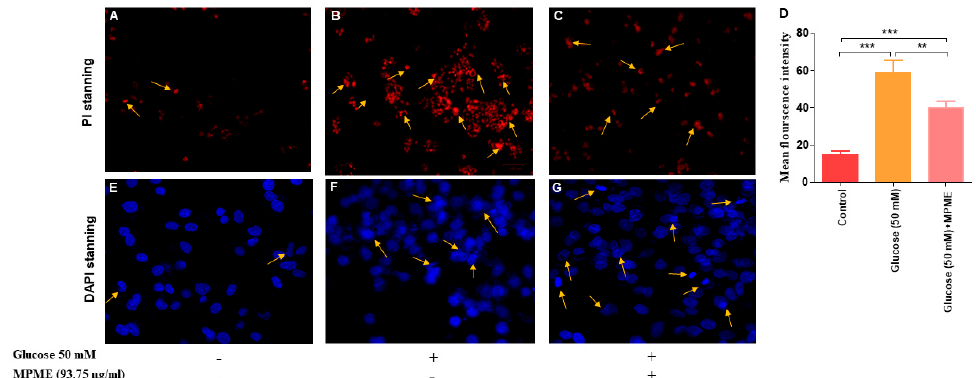
Figure 5. PI is a membrane-impermeant dye and stains only dead cells. Treatment of methanolic heartwood extract of Pterocarpus marsupium (MPME) 93.75 µg/mL for 24 h rescued the high glucose